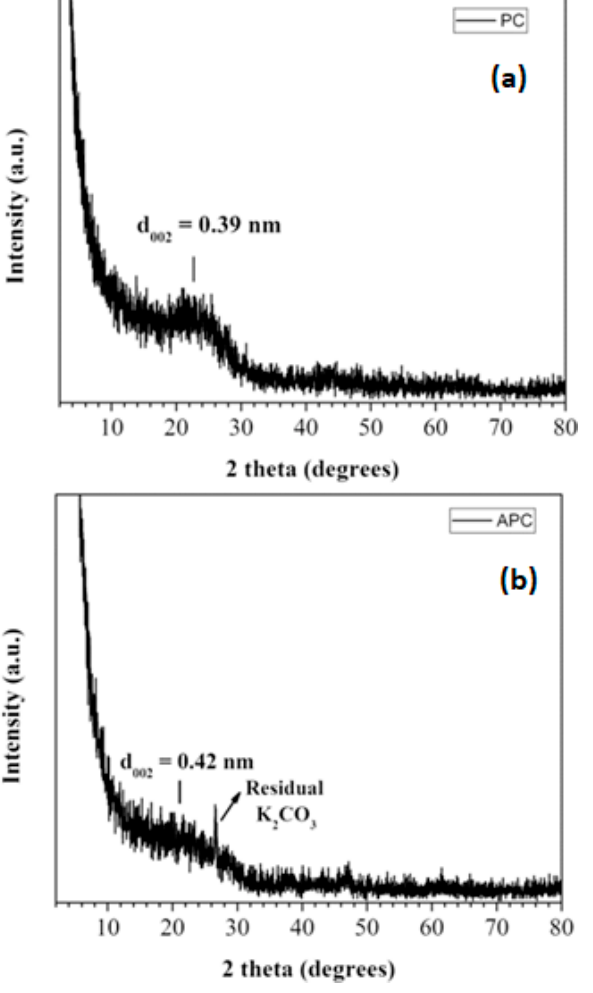
Figure 3. XRD patterns of the PC ( a ) and APC ( b ) powders. APC additionally contained traces of residual K 2 CO 3 .